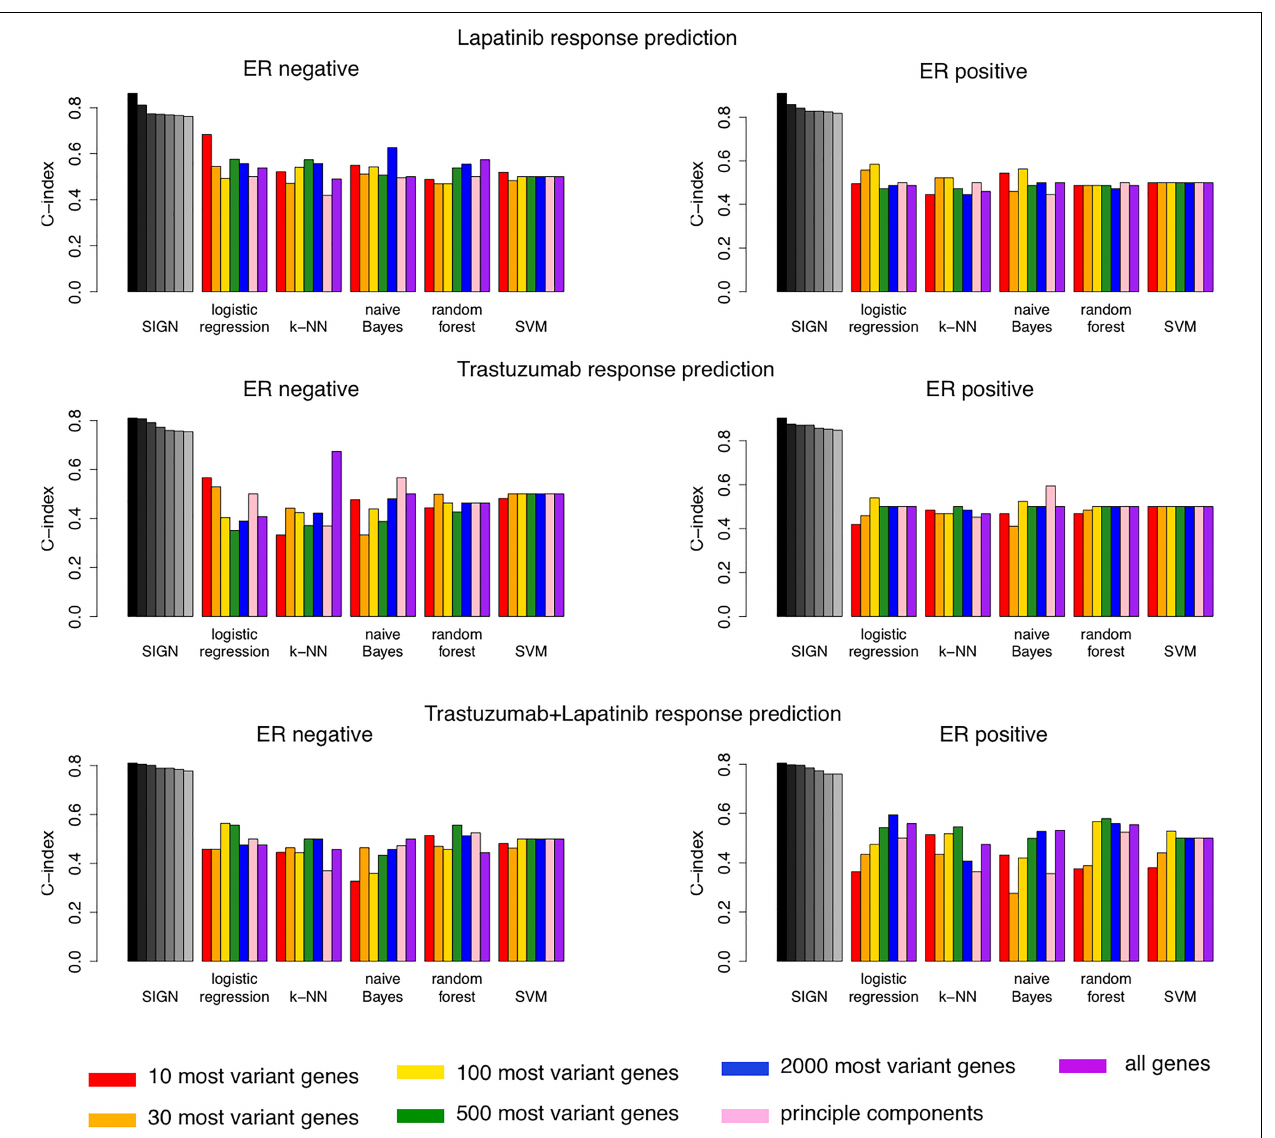
FIGURE 4 | Comparison of performance of top seven biomarkers of drug response using Similarity Identification in Gene Expression (SIGN) and 35 machine learning models built combining five machine learning methods and seven different feature selection approaches.